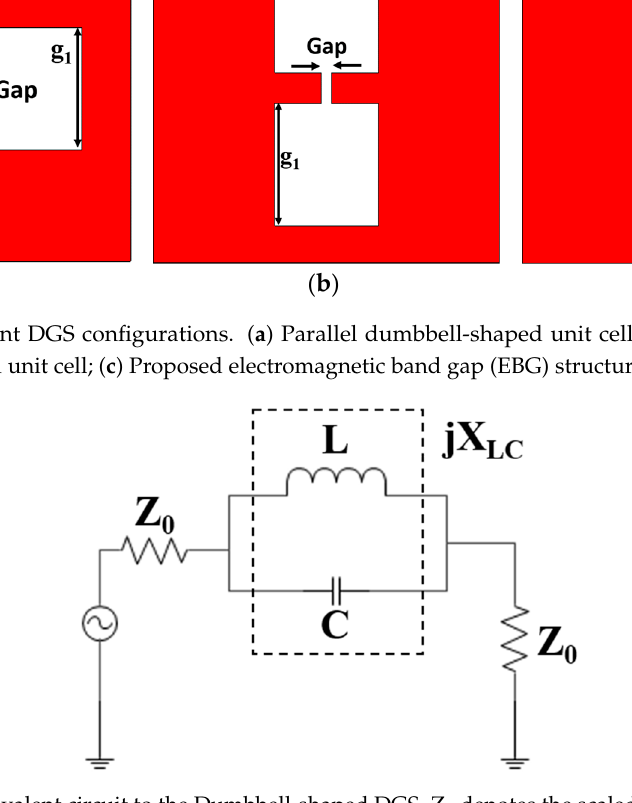
Figure 5. An equivalent circuit to the Dumbbell-shaped DGS. Z 0 denotes the scaled impedance level of the in/out terminated ports.